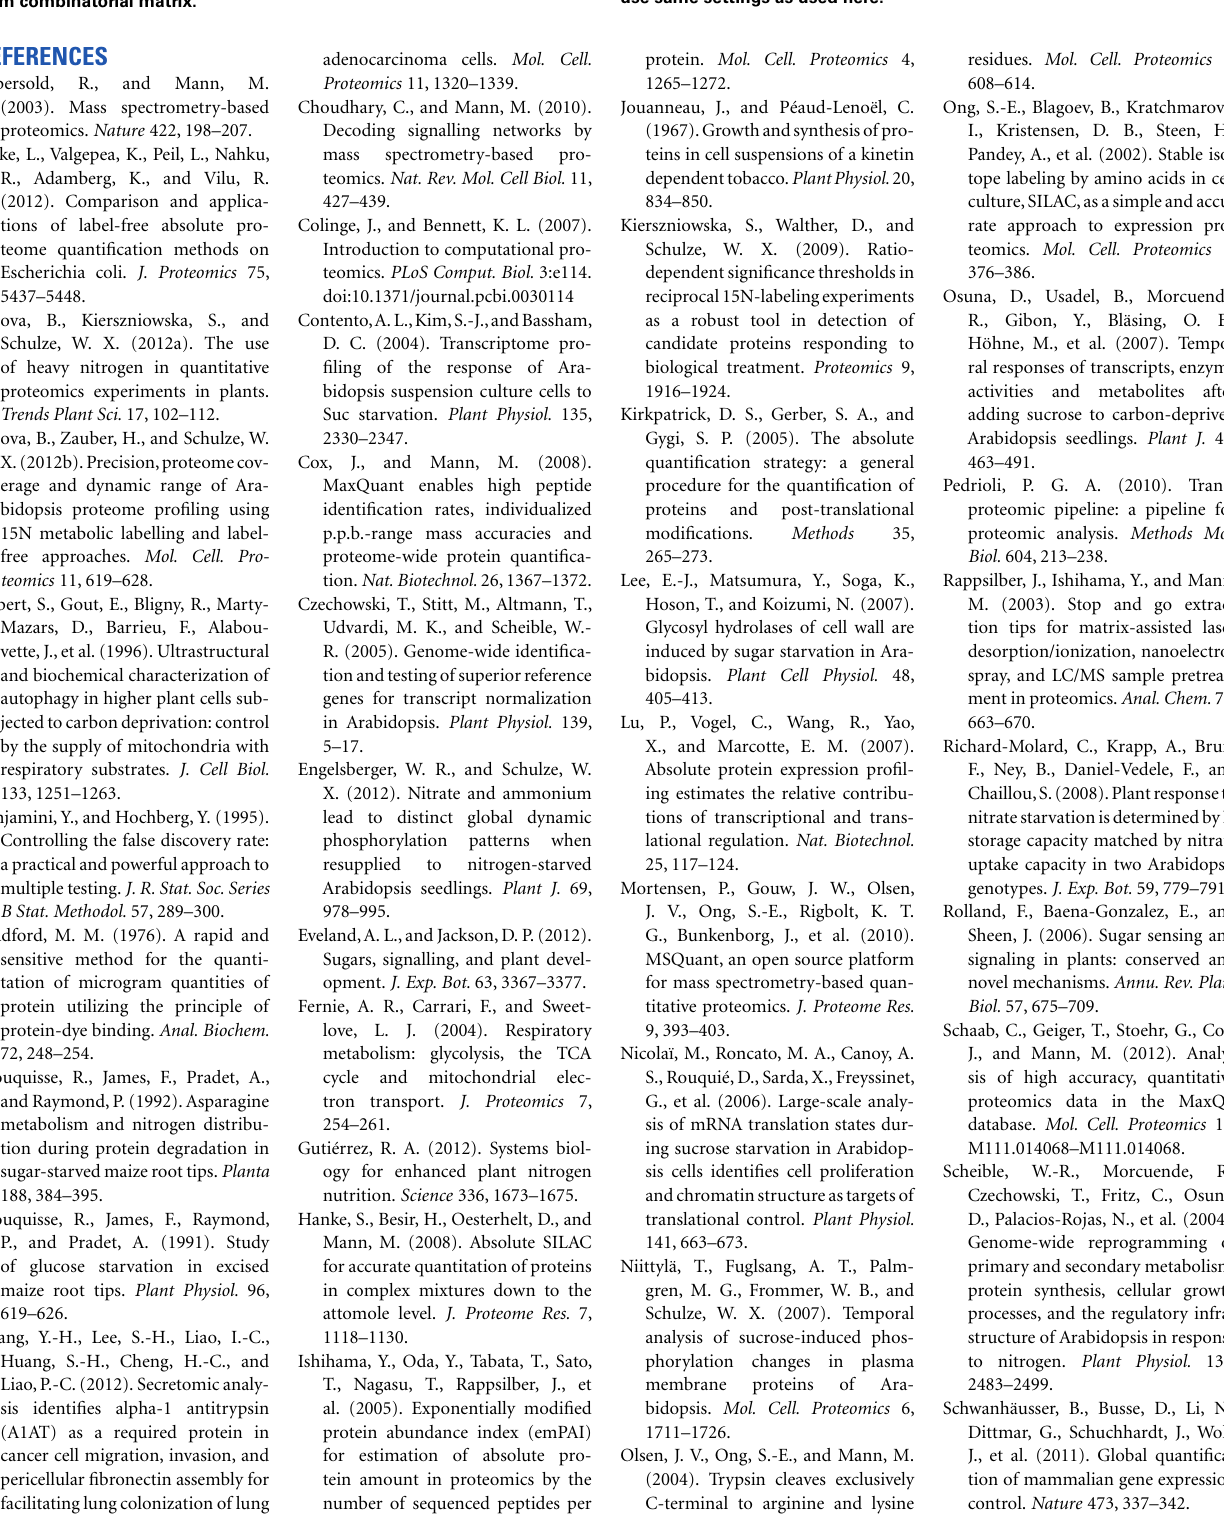
Data Sheet S3 | Results from nitrogen and sucrose starvation